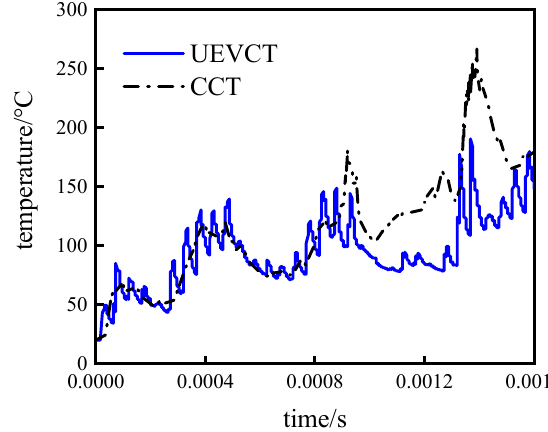
Figure 7. Comparison curve of cutting temperature.